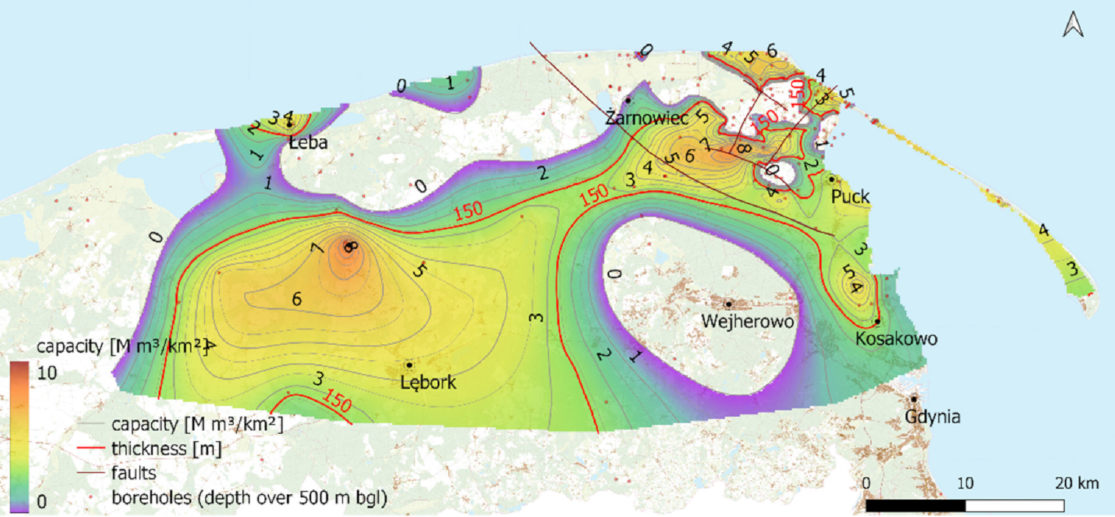
Figure 5. The storage capacity of liquid fuels in the rock salt layer in northern Poland, operational caverns (target cavern